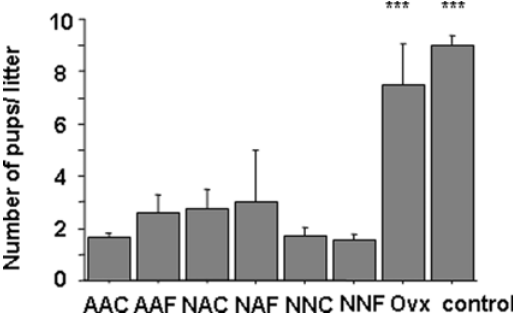
Figure 4. Number of pups by litter in each group. Size of the litter was recorded in each group as compared to unmanipulated mice (control) and to mice after unilateral ovariectomy (Ovx). The asterisks indicate significant differences (p , 0.001) between manipulated groups and control groups. All data are expressed as mean 6 SEM.